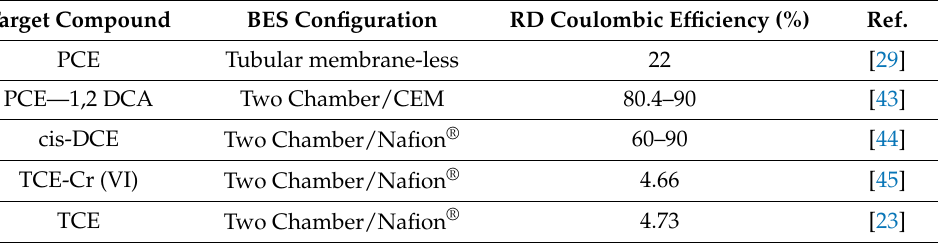
Table 3. The efficiency of BES in the stimulation of reductive dechlorination of certain Chlorinated Aliphatic Hydrocarbons